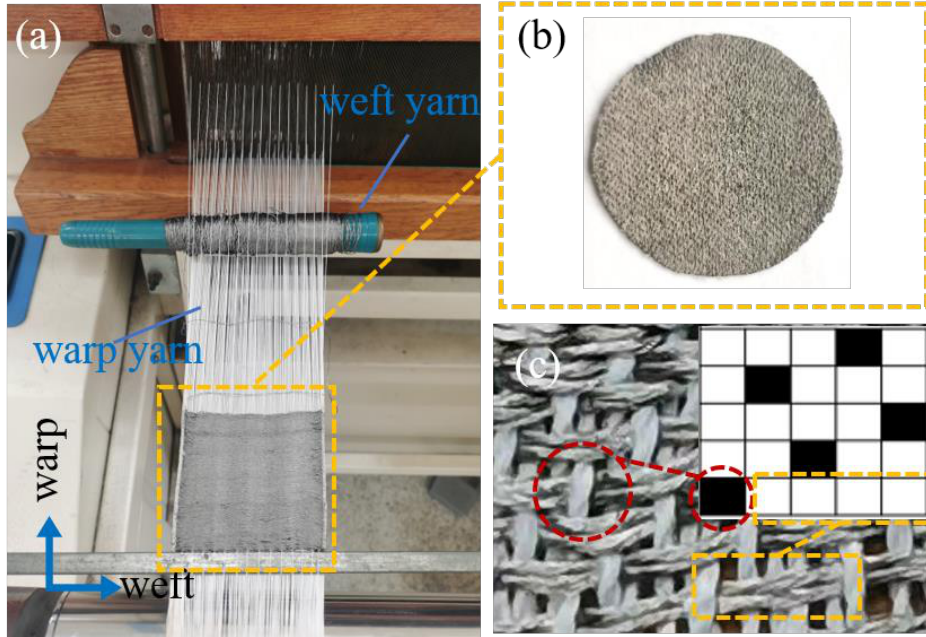
Figure 1. ( a ) The fabrication of the woven fabric in the loom. ( b ) The image of woven fabric electrode. ( c ) Weave diagram and physical diagram of 5/2 sateen (the front side). ( c ) Weave diagram and physical diagram of 5/2 sateen (the front